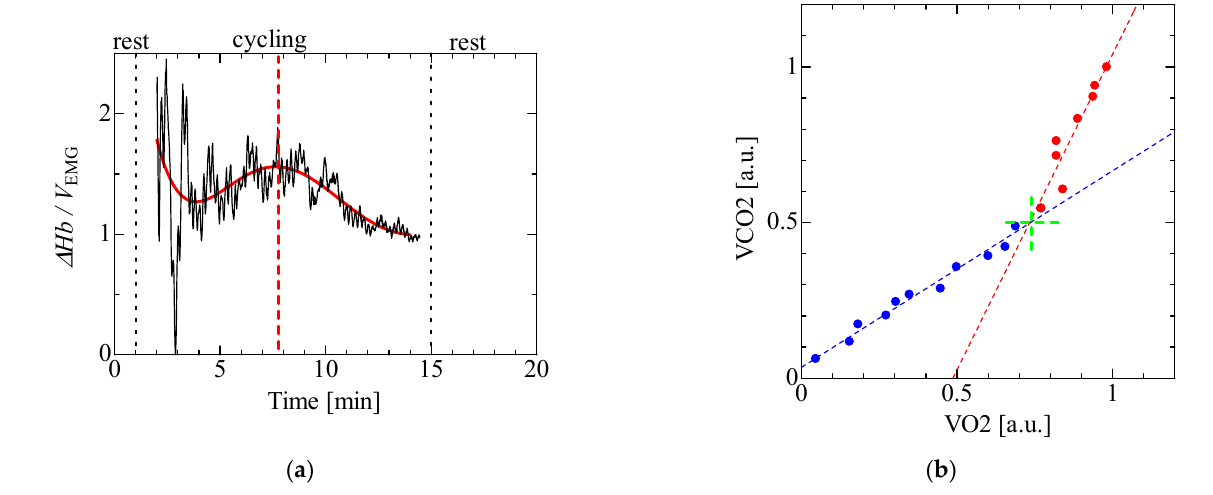
Figure 9. Comparison of the timings of the AT obtained from Δ Hb /EMG and relationship between VO2 and VCO2 in cycling exercise: ( a ) Δ Hb / V EMG and ( b ) relationship between VO2 and VCO2. Table 1. Comparison of the timings of the AT obtained using the proposed sensor and a commercial sensor for the three participants.